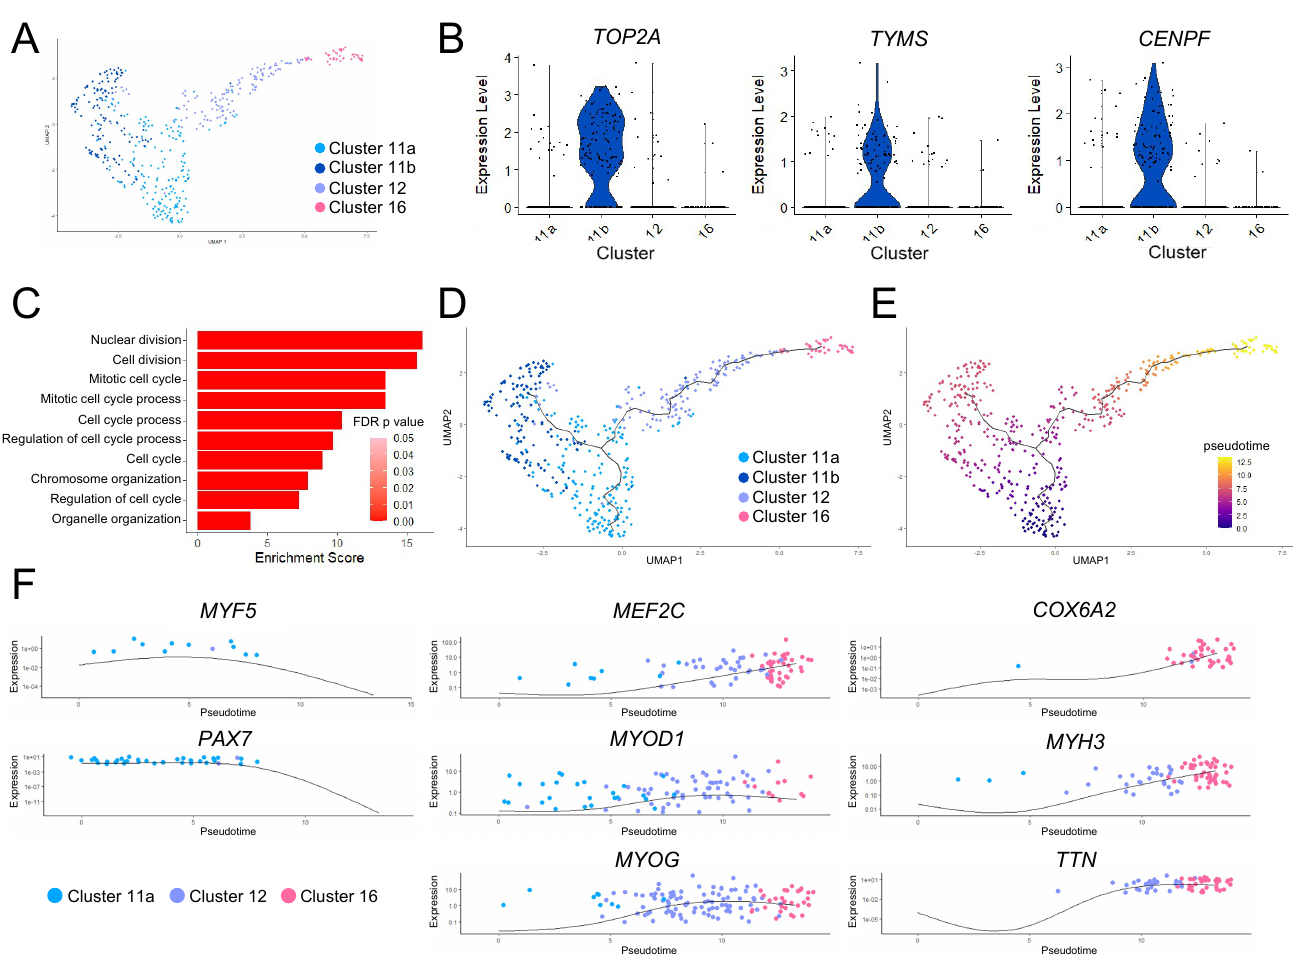
Figure 2. Pseudotime ordering and trajectory analysis of the skeletal myogenic lineage. ( A ) UMAP of the three skeletal myogenic clusters. Cluster 11 is subdivided into Subclusters 11a and 11b (see main text for details). ( B ) Violin plots showing that cell cycle-related genes TOP2A , TYMS , and CENPF are enriched in Subcluster 11b. ( C ) GO term enrichment in Subcluster 11b. ( D , E ) Pseudotime ordering and trajectory analysis of ( A ). The line indicates the differentiation trajectory. ( D ) Cell cluster identities are shown along with ( E ) values of pseudotime. Higher values in pseudotime indicate cells further down the differentiation trajectory. ( F ) Expression of key skeletal myogenic genes is shown over pseudotime along the skeletal myogenic differentiation